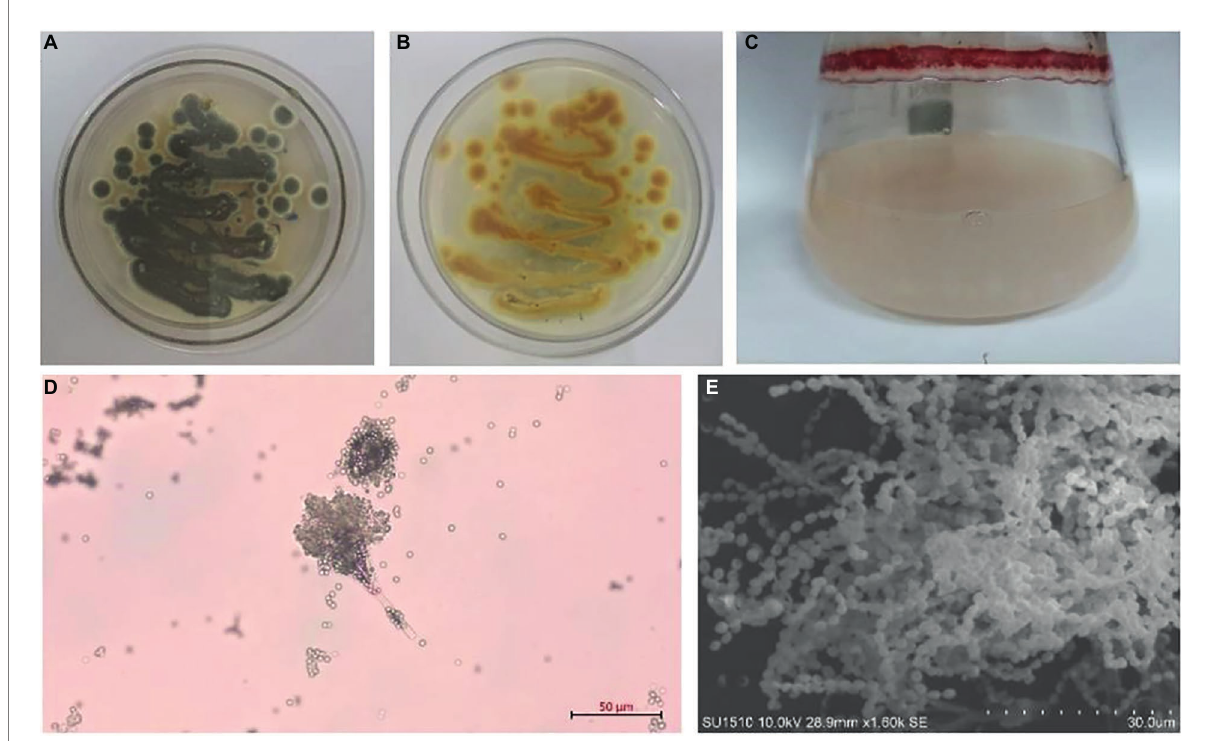
FIGURE 1 Talaromyces amestolkiae (CBS 365.48) in vitro . (A,B) Growth of T. amestolkiae on M1 semisolid medium at 30 ° C after 7 d and (C) in liquid M1 medium at 30 ° C after 7 d; (D) conidia, scale bar = 10 μ m; (E) T. amestolkiae ,